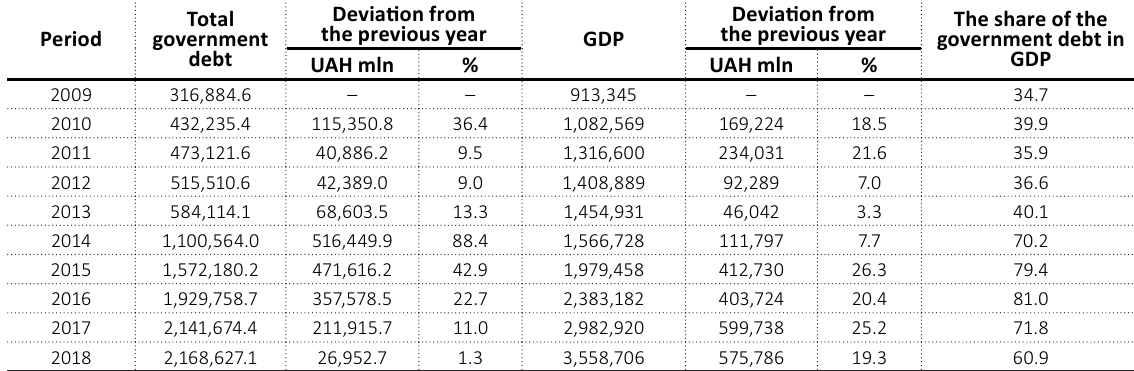
Table 5. Government debt-to-GDP ratio in Ukraine, UAH mln